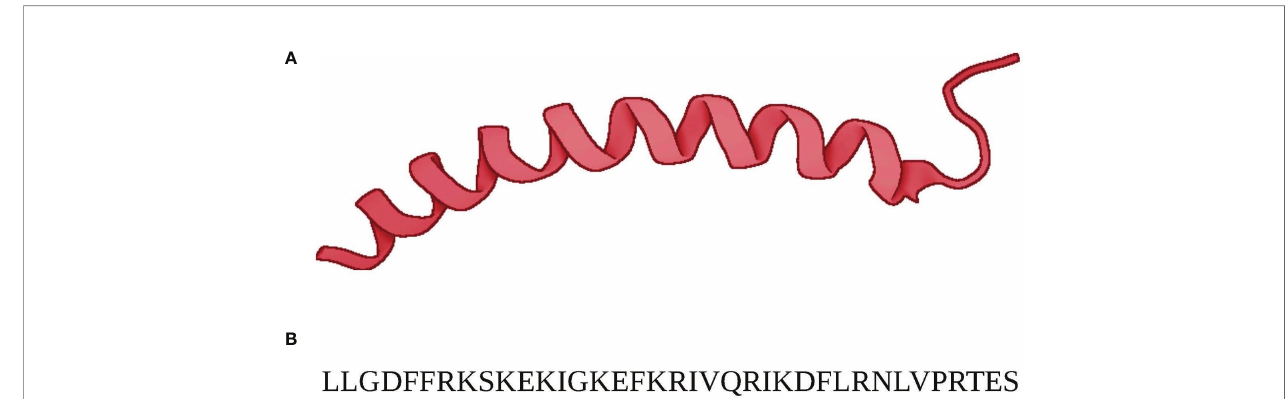
FIGURE 1 | (A) The structure of (13)C,(15)N-labeled LL-37 determined by three-dimensional triple-resonance NMR spectroscopy for LL-37 in complex with micelles. (9) LL-37 ’ s alpha-helical secondary structure is evident. (B) The 37 amino acid sequence of LL-37. At physiological pH LL-37 has a resulting net charge of